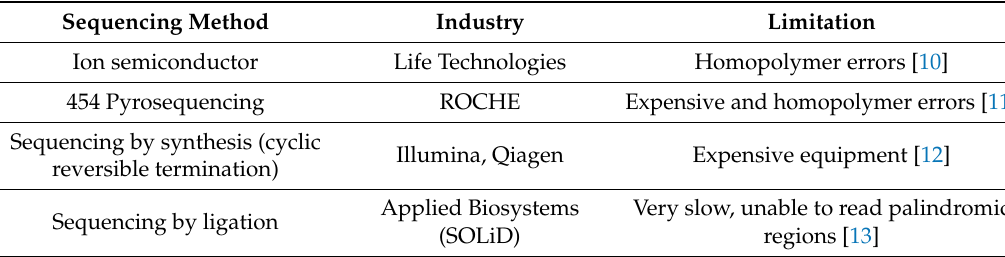
Table 1. Limitations of short-read sequencing technologies.